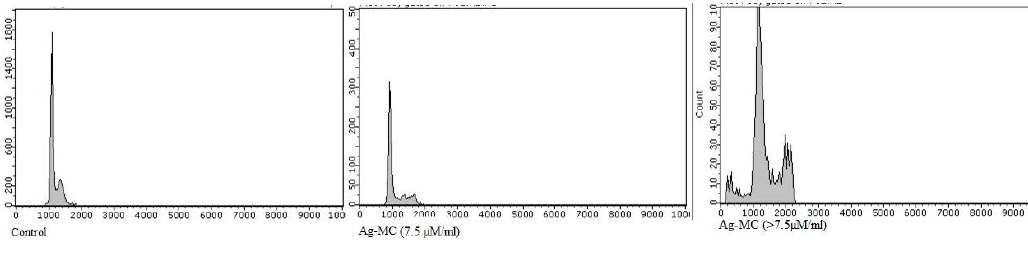
Figure 10. Cell cycle analysis in flow cytometer.